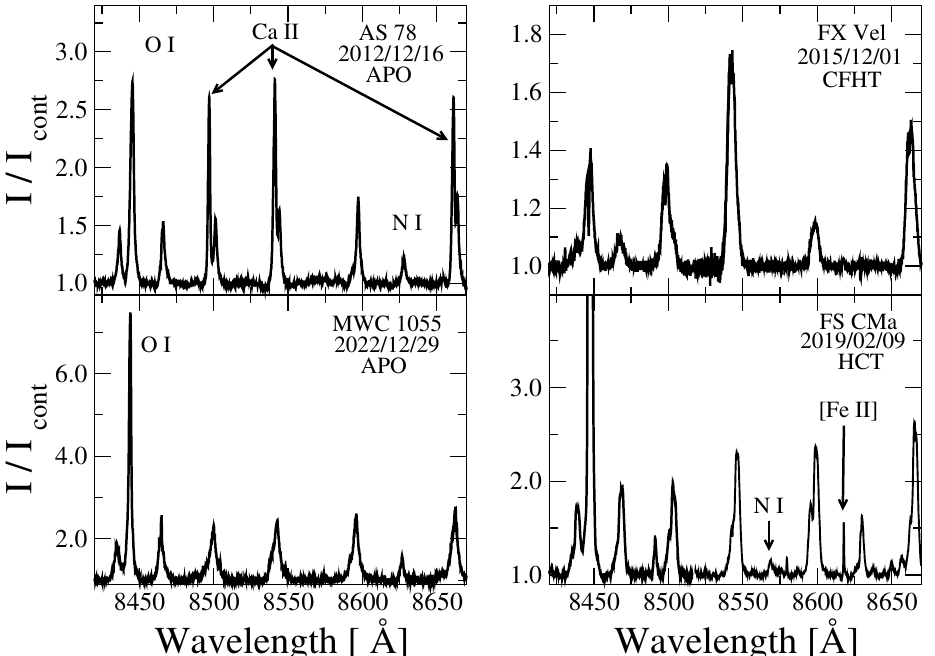
Figure 3. Selection of emission-line profiles in the Paschen line region of some FSCMa group objects. Objects’ names, observing dates, and the observatory ID are shown in each panel. Most of the lines are those of hydrogen (Pascen series). Lines of other elements are marked. Intensity is normalized to the local continuum, and heliocentric wavelength scale is shown in Å.